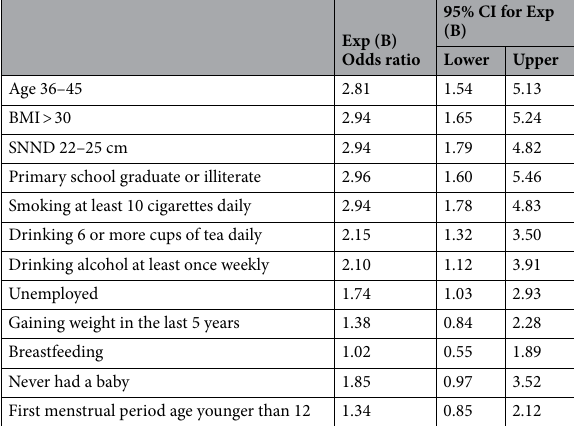
Table 4. Logistic regression model of risk factors—enter method results. Pseudo (Nagelkerke) R 2 = 0.368, Hosmer–Lemeshow χ 2 = 26.121, p = 0.001. CI confidence interval, OR odds ratio, BMI body mass index, SNND distance from the sternal notch to the nipple.